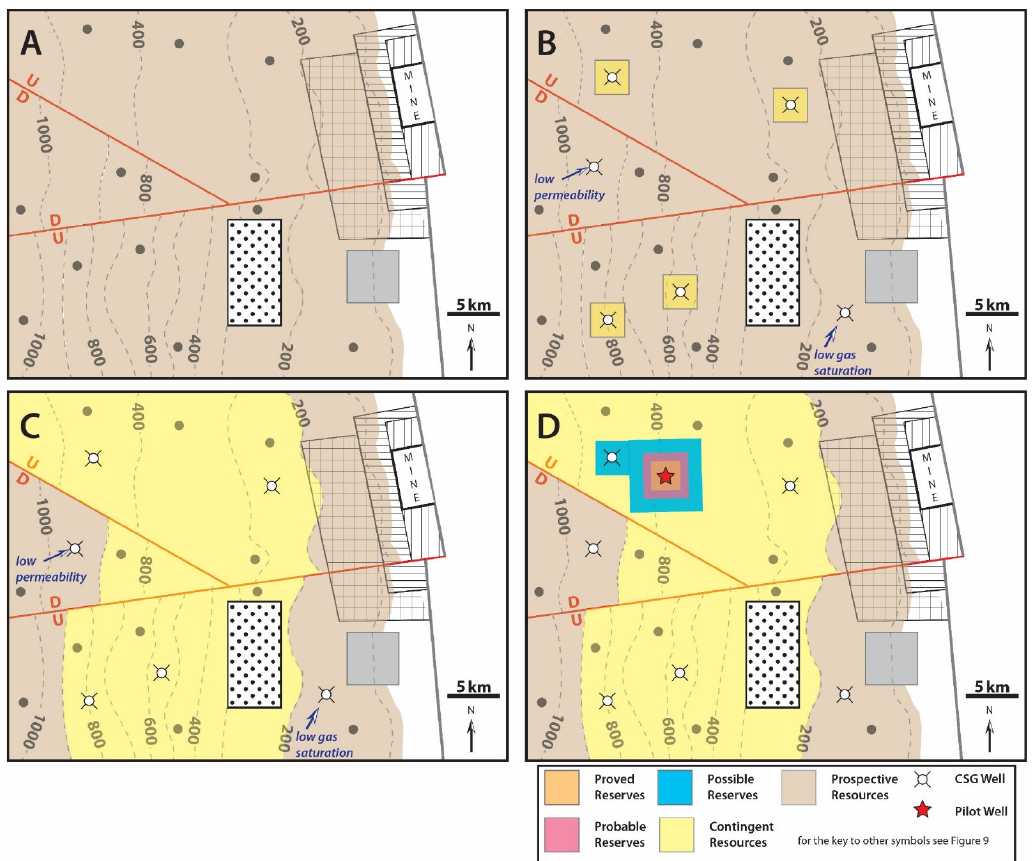
Figure 15. Hypothetical case study showing distribution of ( A ) Prospective Resources, ( B ) initial assignment of Contingent Resources, ( C ) full extent of Contingent Resource after “rubber banding”, and ( D ) Reserves distribution after a successful pilot well.